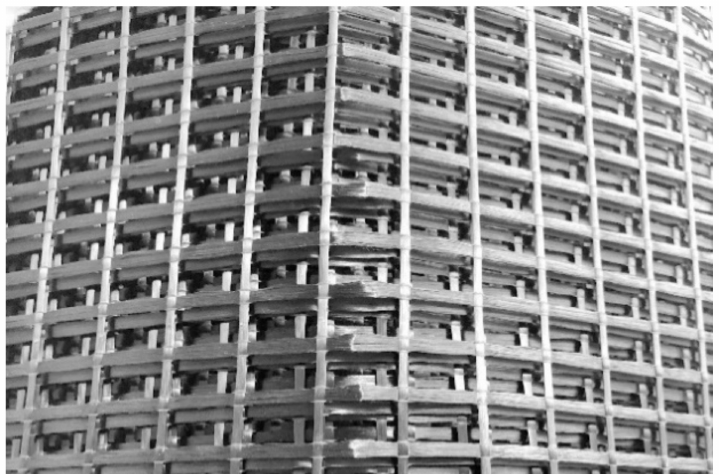
Figure 9. Damage in CF textiles due to